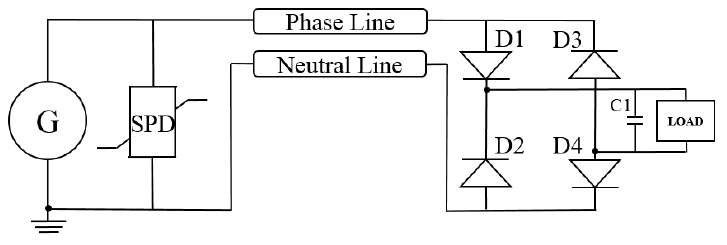
Figure 11. The low-voltage single-phase power system (Model 2).